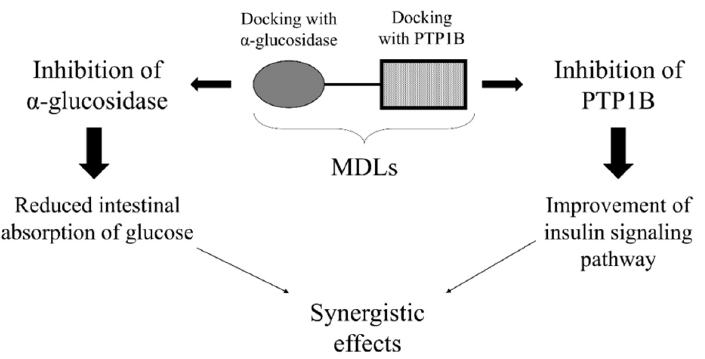
Figure 4. Mechanism of action of a dual PTP1B/ α -glucosidase inhibitor. Such molecules possess a structure able to interact with both targets, thereby leading to their inhibition.